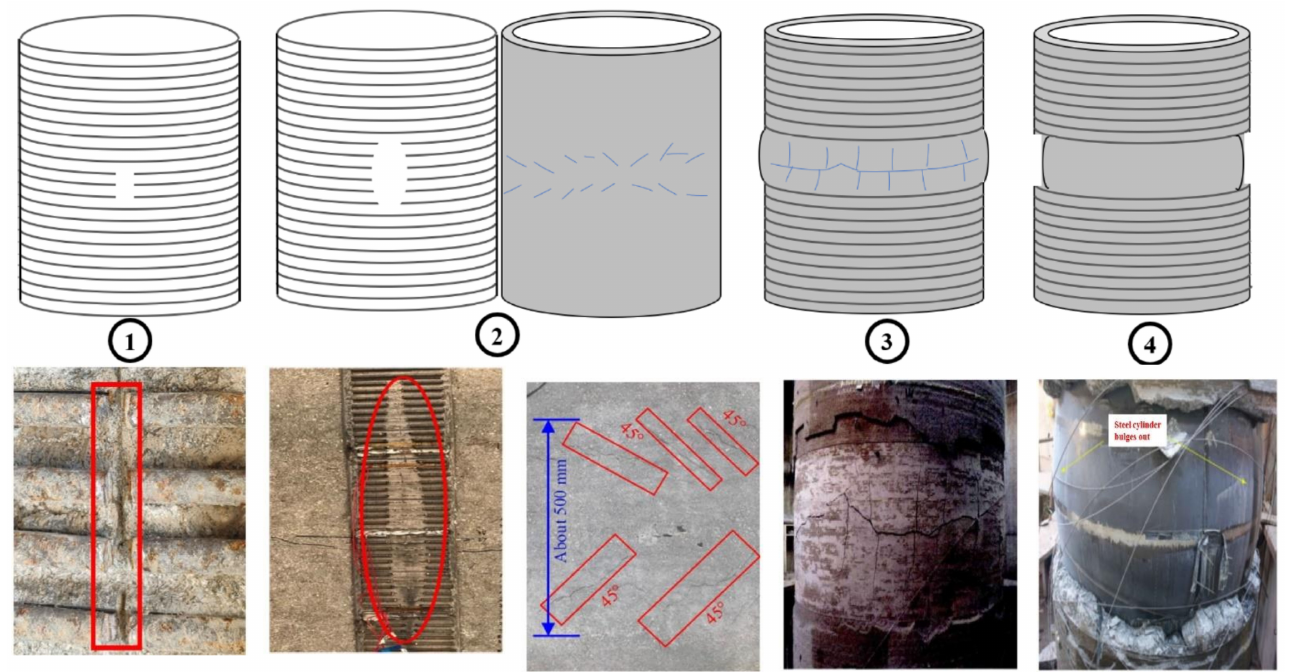
Figure 3. ECP components in ECP finite element model